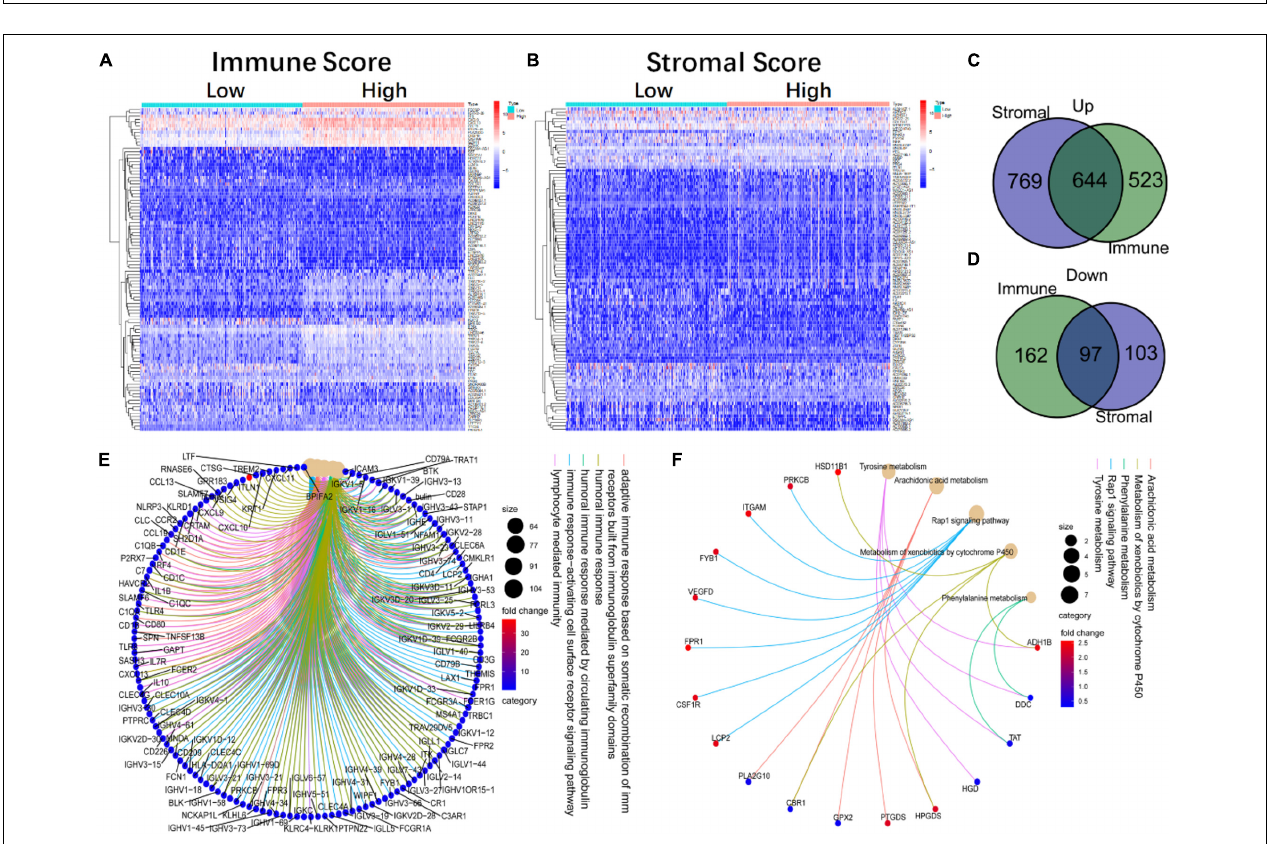
FIGURE 1 | The correlation between score and survival rate of LUAD patients. (A) Kaplan–Meier survival curve of ESTIMATE score and survival rate of LUAD patients ( p = 0.046). (B) Kaplan–Meier survival curve of immune score and survival rate of LUAD patients ( p = 0.022). (C) Kaplan–Meier survival curve of stromal score and survival rate of LUAD patients ( p = 0.095).